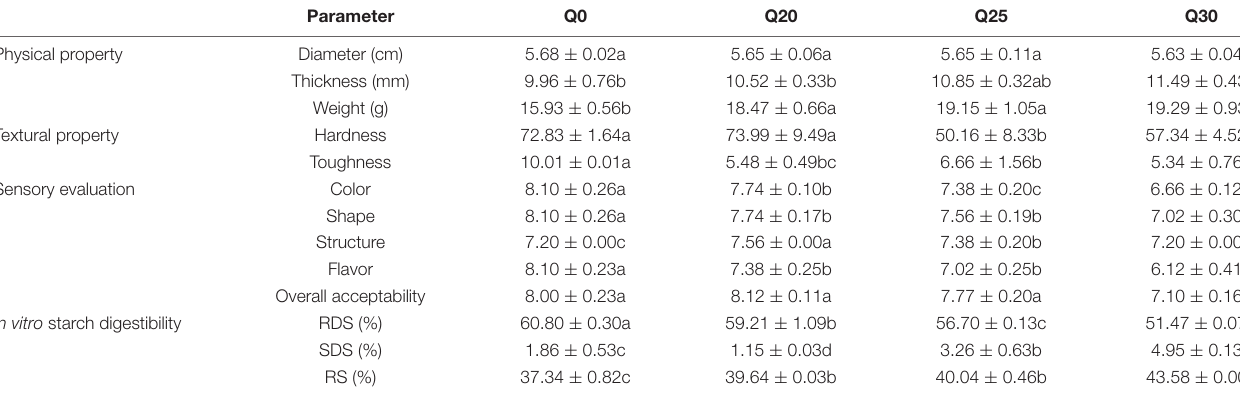
TABLE 4 | Effect of quinoa content on the physical property measurements, textural properties, sensory evaluation, and in vitro starch digestibility of crispy biscuits. Parameter